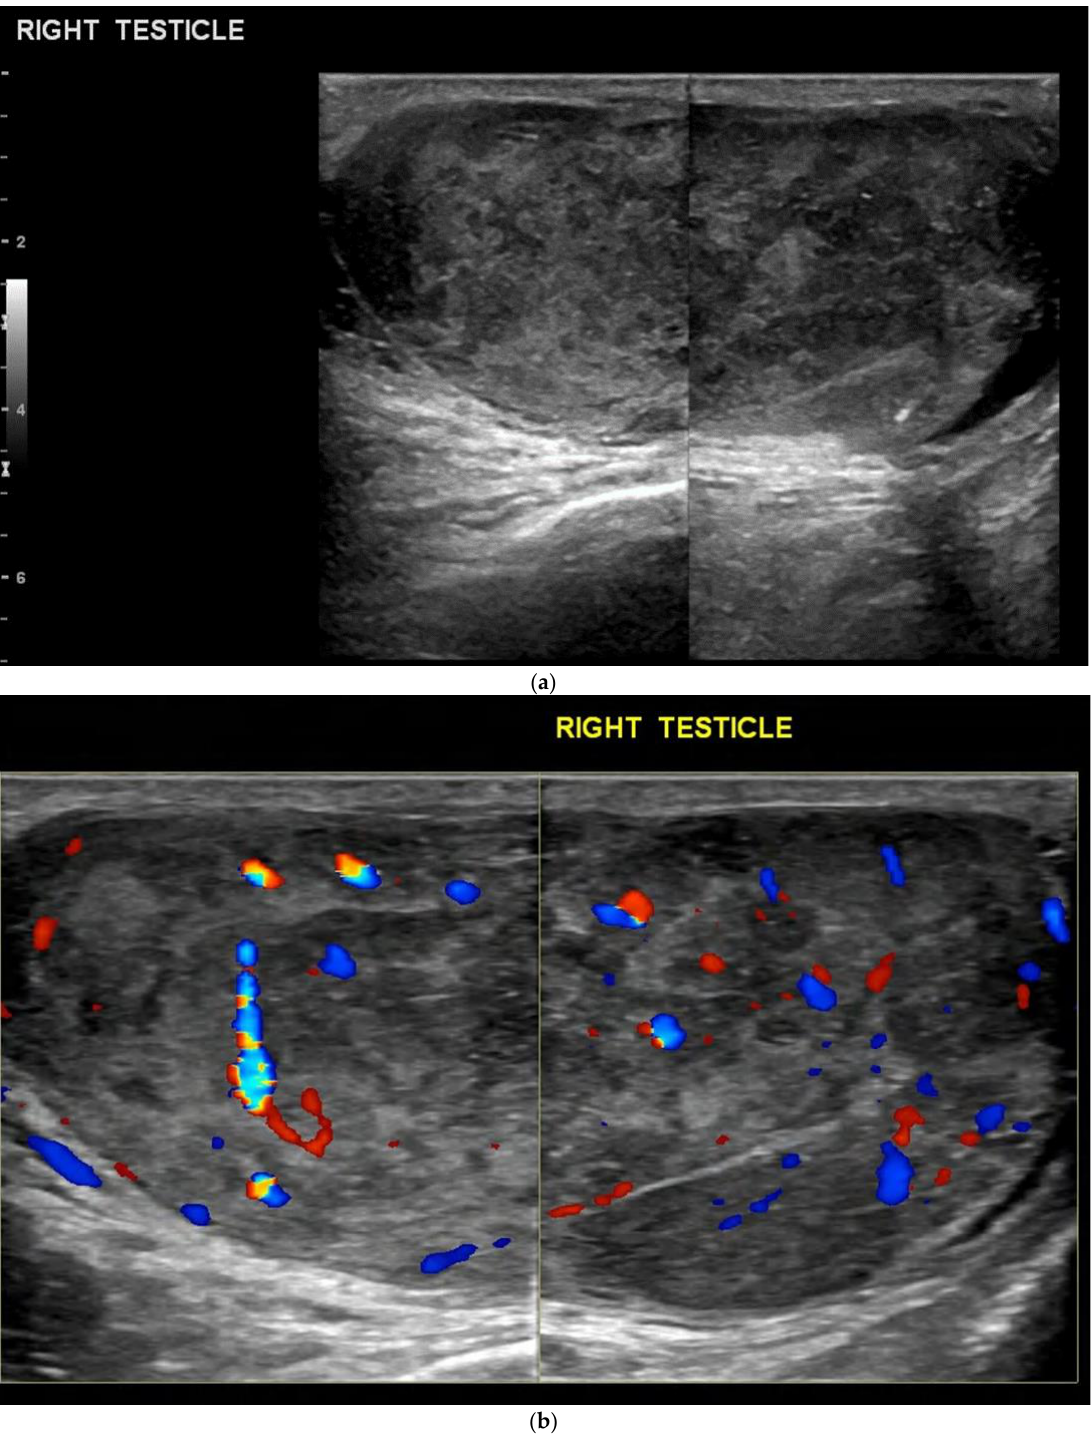
Figure 1. ( a ) B-mode ultrasound shows a heterogeneous large mass infiltrating and enlarging the right testis, containing areas of calcification and small cystic foci. ( b ) Colour Doppler ultrasound demonstrates increased vascularity throughout the mass.